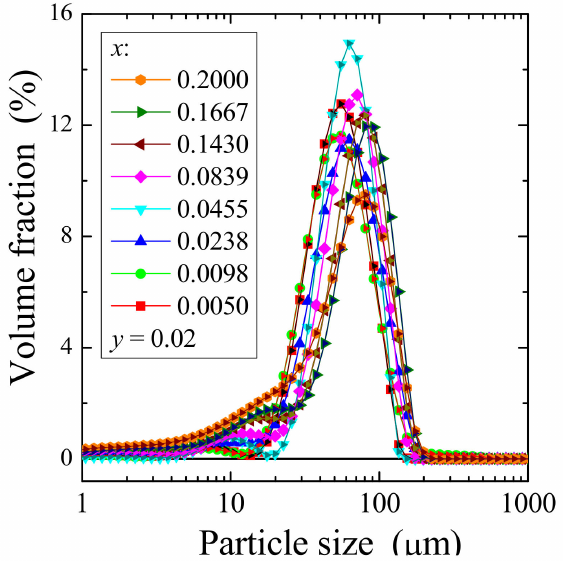
Figure 4. Particle size distribution of CCGMWO